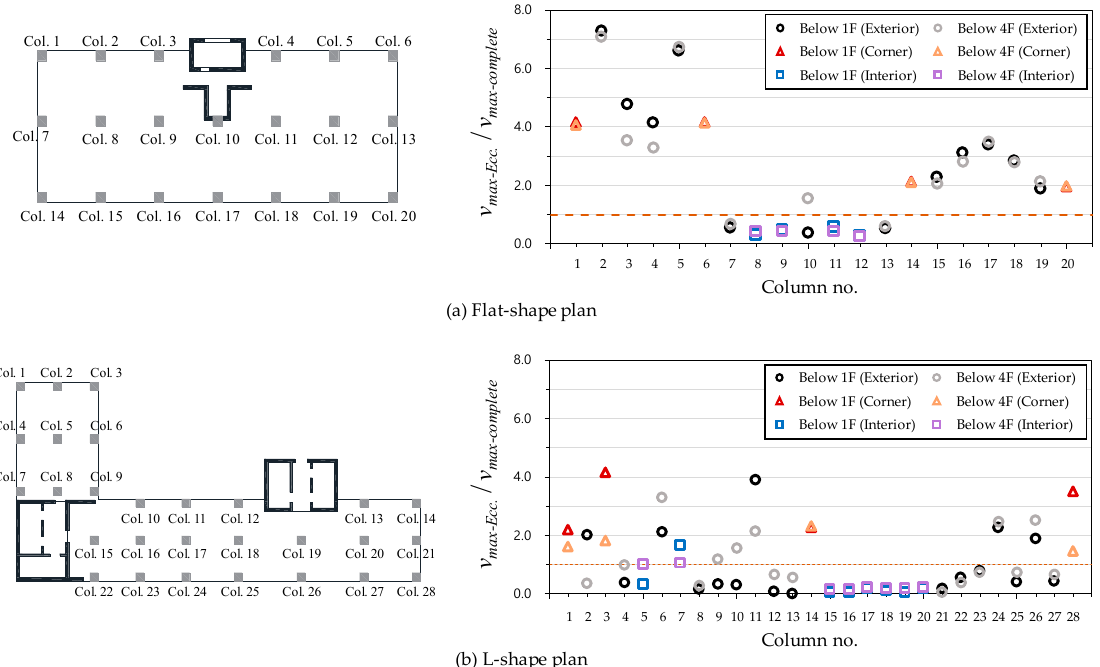
Figure 17. Maximum punching shear stress ratio according to number of stories below the transfer plate (for y-dir. lateral load only). ( a ) Flat-shape plan and ( b ) L-shape plan.